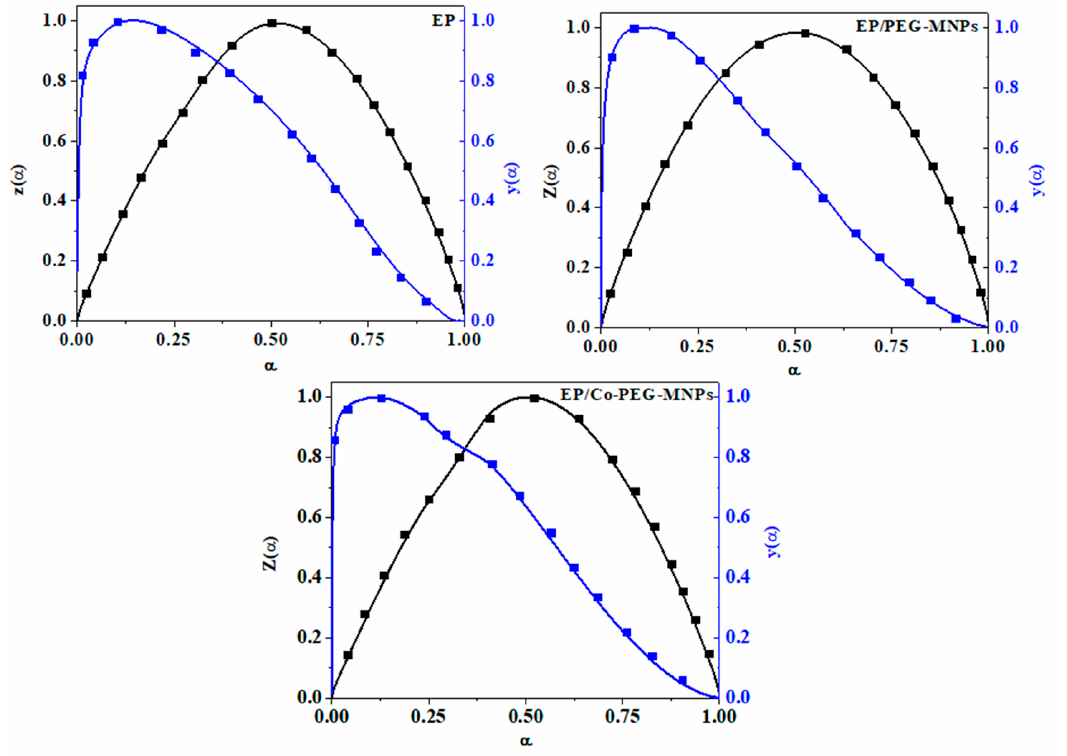
Figure 11. The shape and alteration pattern of y( α ) and z( α ) versus the extent of reaction captured by the Malek model. Table 2. The quantities of α p , α m and α p ∞ due to Malek model as a function of heating rate.